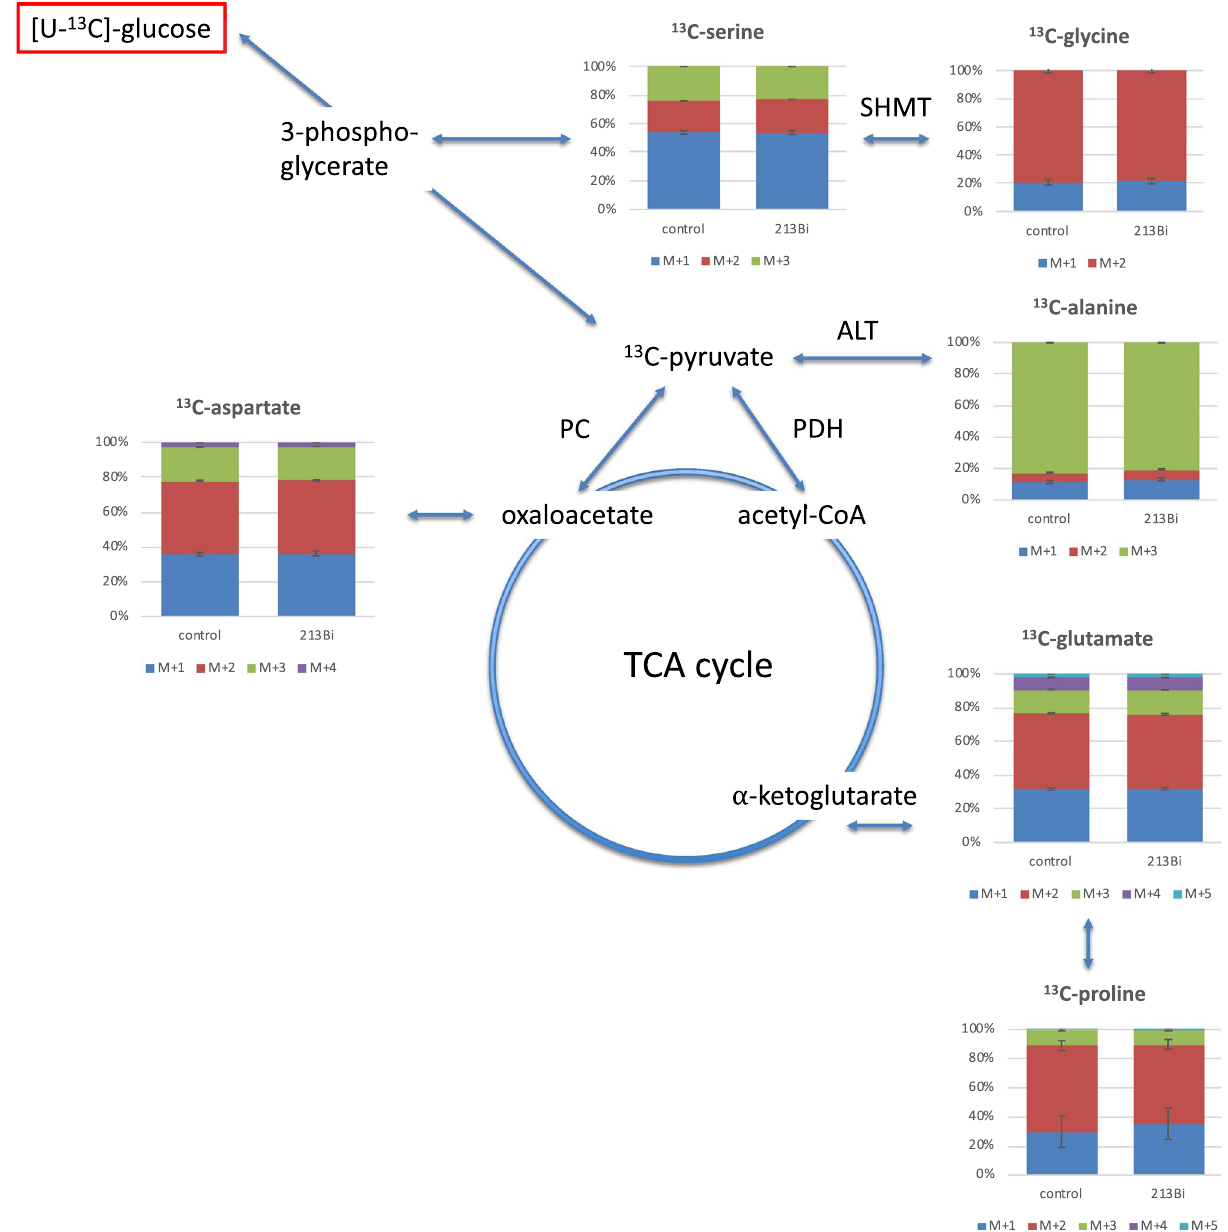
Figure 3. Isotopologue profiling with regard to 13 C in alanine, aspartate, glutamate, glycine, proline, and serine following incubation of EJ28Luc cells with 213 Bi-anti-EGFR-MAb compared to untreated controls. Just as in Fig. 2 showing overall enrichment of 13 C, a significantly lower enrichment of 13 C in the various C-atoms following 213 Bi-anti-EGFR-MAb treatment was only observed for alanine, aspartate, glutamate, and serine but not for glycine and proline. SHMT serine hydroxymethyl transferase, ALT alanine aminotransferase, PC pyruvate carboxylase, PDH pyruvate